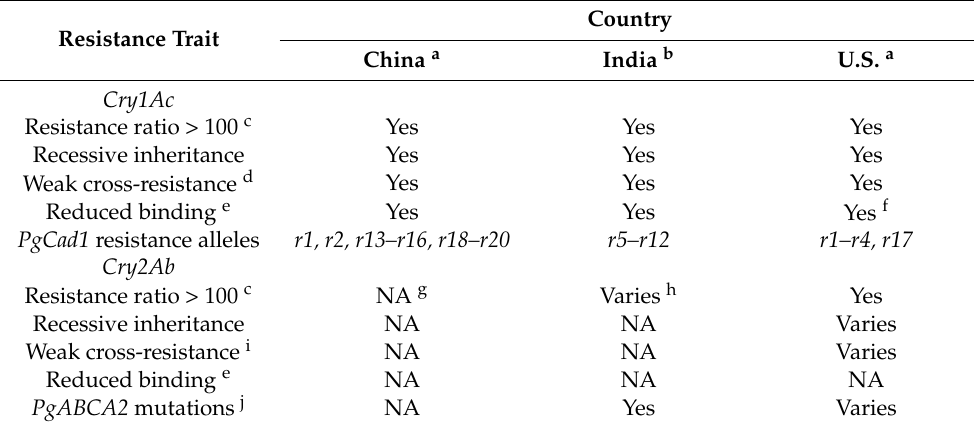
Table 1. Summary of the mode of resistance to Bt toxins Cry1Ac and Cry2Ab in pink bollworm from China, India, and the United States (see text for details and references). Country Resistance Trait China a India b U.S.